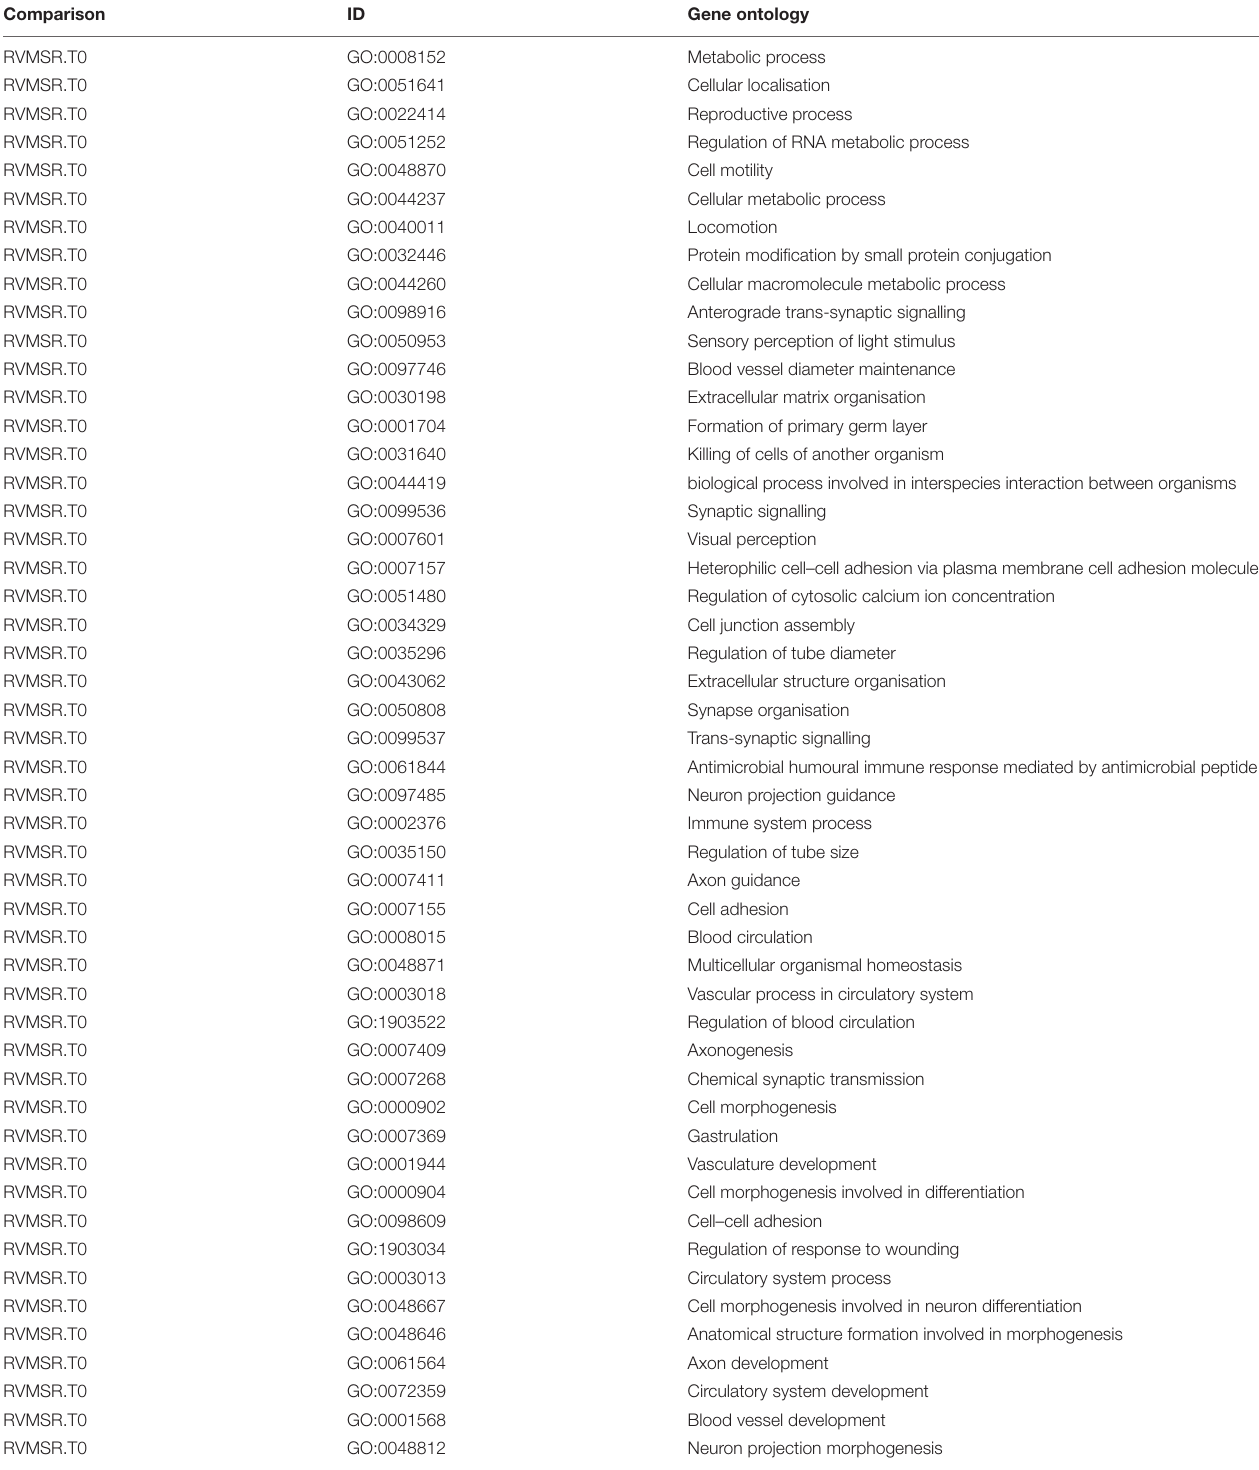
TABLE 5 | Top 50 GO gene sets differentially regulated in R and MSR groups throughout the trial.